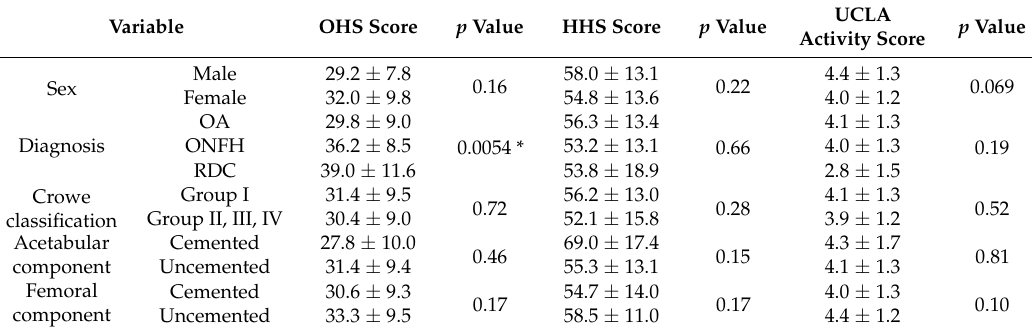
Table 3. Preoperative clinical